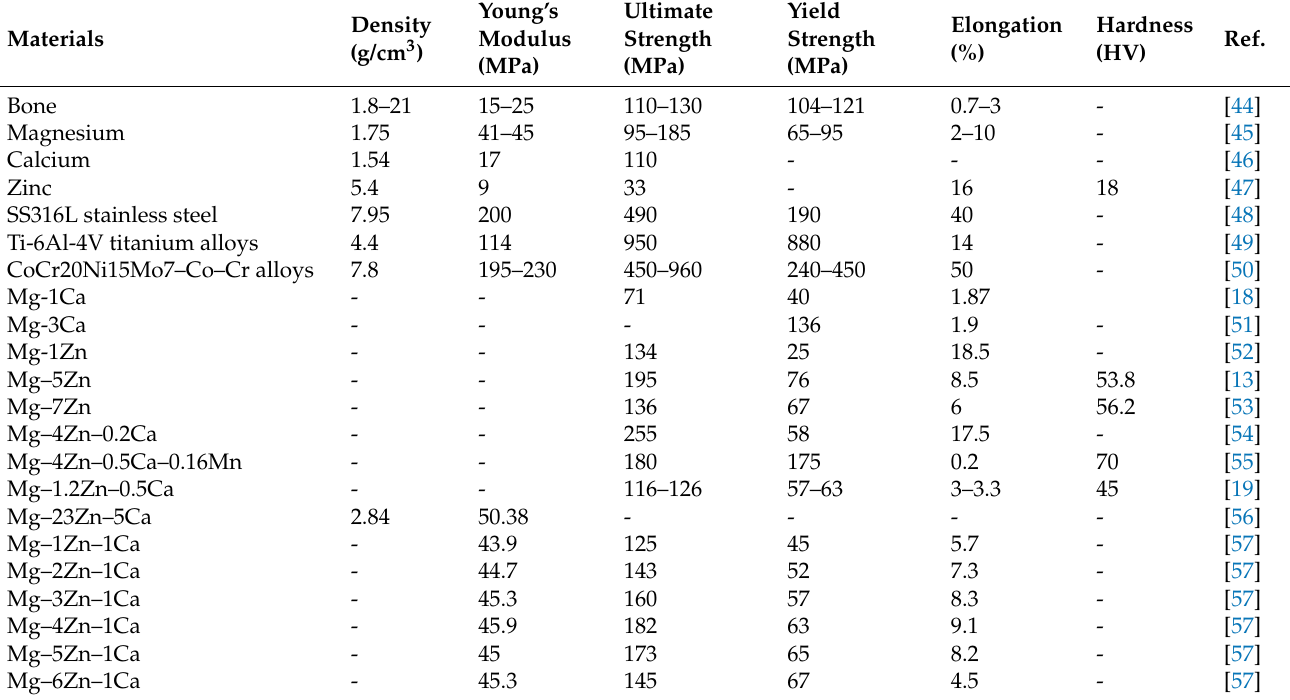
Table 1. Mechanical properties of some biodegradable biomaterials in comparison with classical